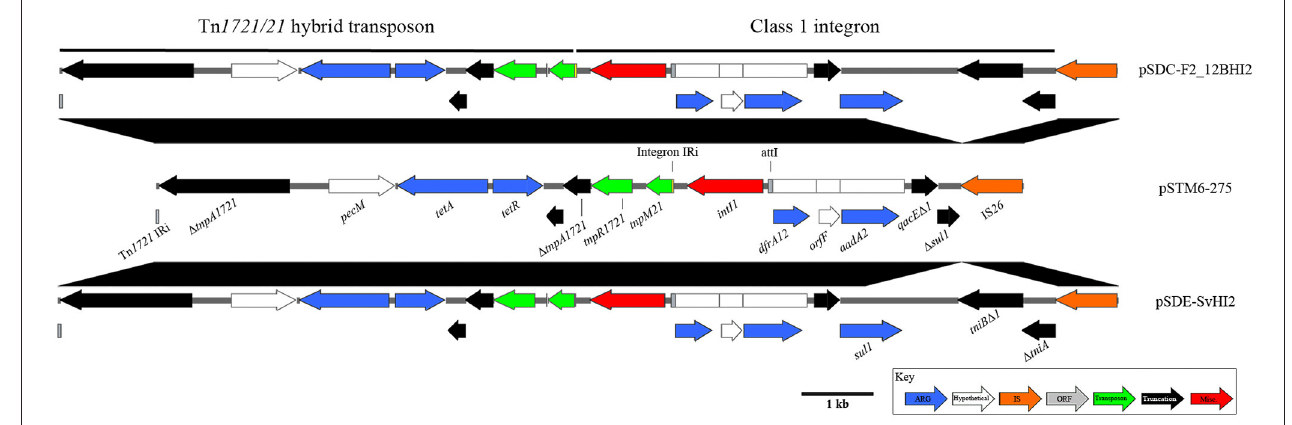
FIGURE 3 | Diagrams and comparisons of Tn 1721 /Tn 21 hybrid transposons carrying a class 1 integron. Clinical class 1 integron-based locus, with comparisons to the highly similar structure found in pSTM6-275 (center). Genes are colored by function, with black connecting regions indicating homology between